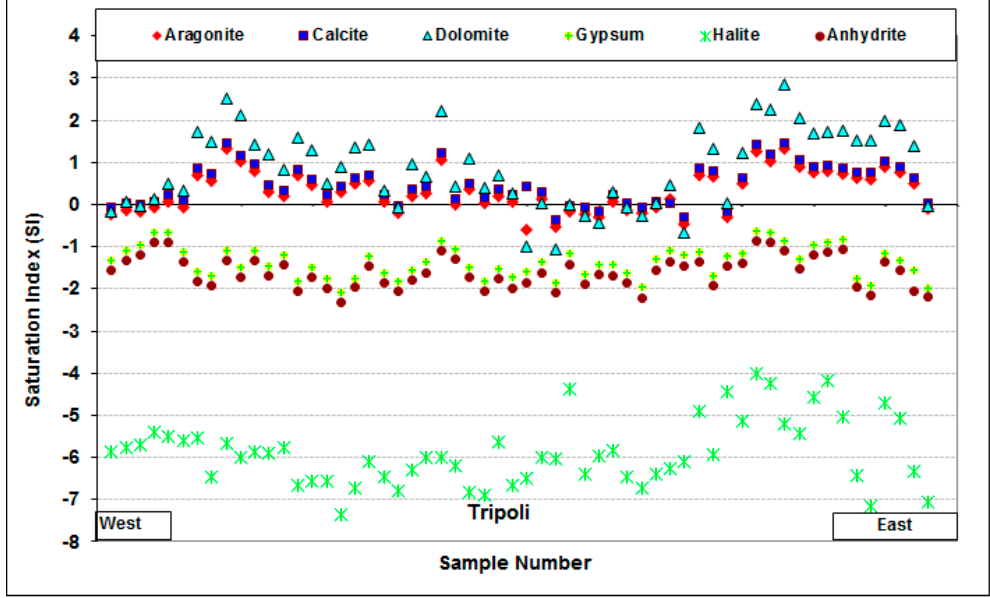
Figure 11. Calculated saturation indices of groundwater samples with respect to selected minerals.